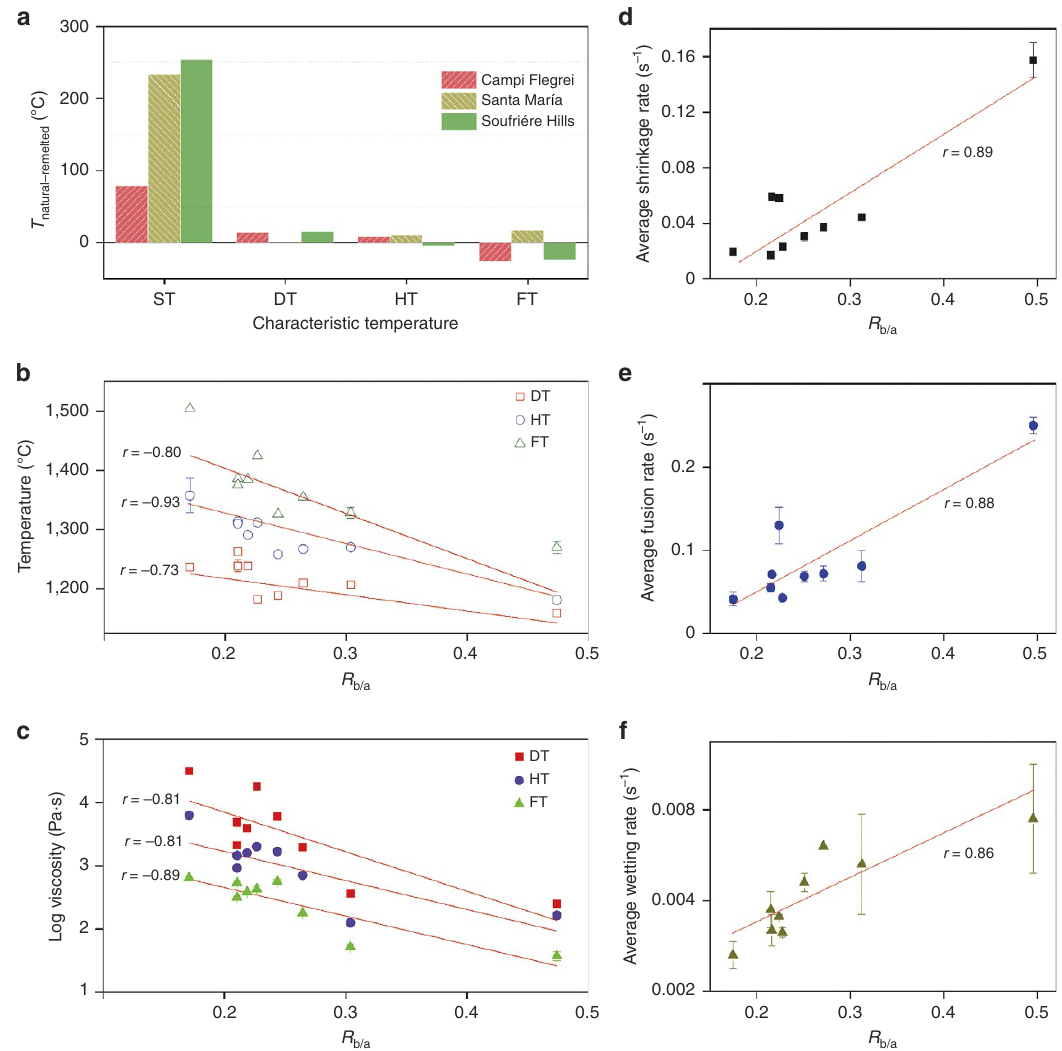
Figure 5 | Chemical parameterization of volcanic ash fusion and rheology. ( a ) Net difference between the characteristic temperatures of three natural volcanic ash and that of three remelted ash from the same samples ( T natural (cid:2) remelted ). ( b ) Chemical dependence of the characteristic temperatures using the ratio of acidic to basic major oxides ( R b/a ). The data show good linearity and the best fits yield the following regressions: DT ¼ 1,282–263 R b/a ( r ¼ (cid:2) 0.73; n ¼ 9); HT ¼ 1,418–517 R b/a ( r ¼ (cid:2) 0.93; n ¼ 9); and FT ¼ 1,556 þ 762 R b/a ( r ¼ (cid:2) 0.80; n ¼ 9). ( c ) Chemical dependence of the estimated viscosity of molten volcanic ash ( Z ), as a function of R b/a . The data agree equally well with the geochemical composition of the ash and the best fits yield: for DT, log Z ¼ 5.11–6.29 R b/a ( r ¼ (cid:2) 0.81; n ¼ 9); for HT, log Z ¼ 4.24–4.89 R b/a ( r ¼ (cid:2) 0.81; n ¼ 9); and for FT, log Z ¼ 3.58–4.59 R b/a ( r ¼ (cid:2) 0.80; n ¼ 9) ( d – f ) Chemical composition dependence of sample geometry evolution. The data show that the average ( d ) shrinkage rate, ( e ) fusion rate and ( f ) wetting rate are linearly proportional to R b/a (red line, linear fit through the data; r , correlation coefficient to indicate the accuracy of a regression). The values plotted represent the average of two independent experiments, and the s.d. of each sample is